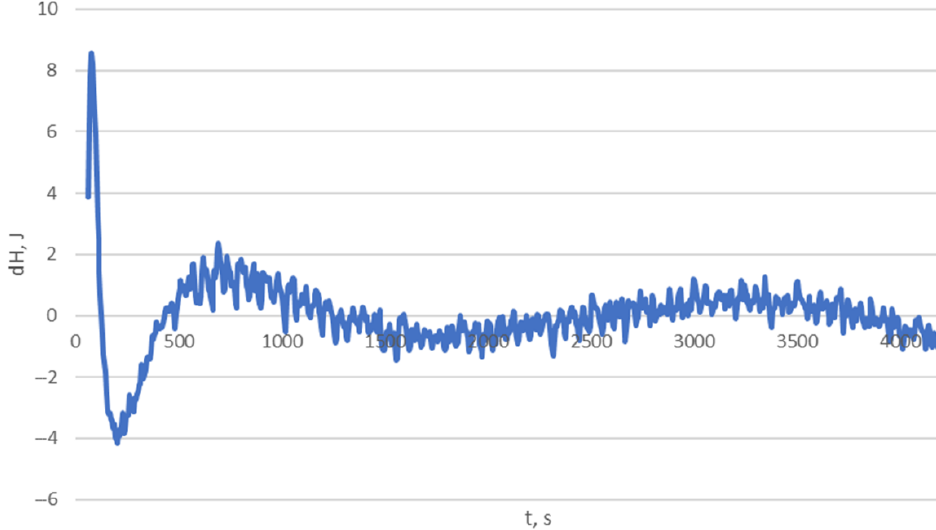
Figure 9. Residual enthalpy after approximation from Table 5.